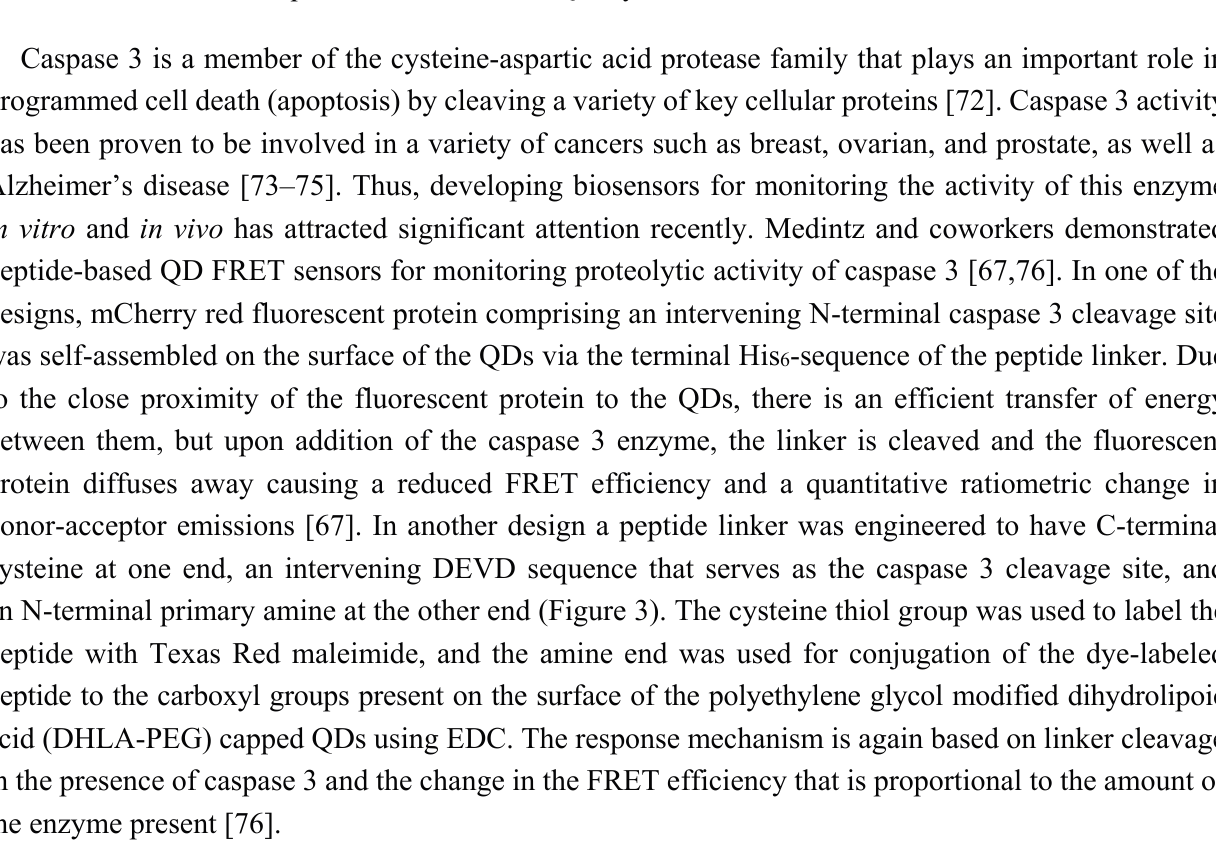
Figure 2. Cleavage of the QD-dye linker by the activity of the analyte causes a disruption of FRET, and a subsequent alteration of the QD-dye emission